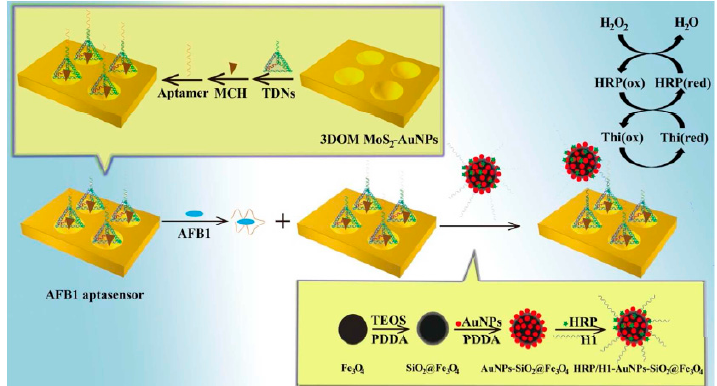
Figure 4. Schema of the protocol of electrochemical AFB1 aptasensor. Reprinted with permission from [42]. Copyright 2018, ACS.